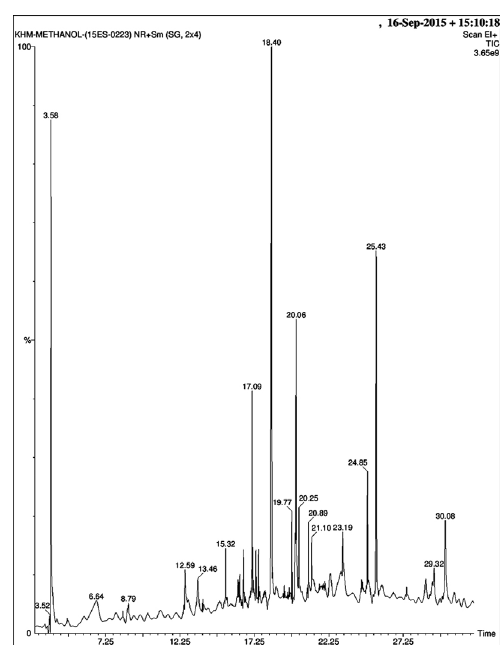
Fig. 4. GC-MS Chromatogram of methanolic extract of P.